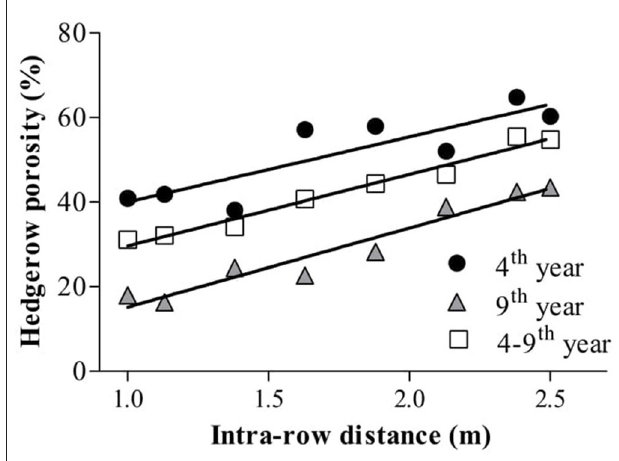
FIGURE 4 | Hedgerow porosity in the fourth and ninth year after planting trees at various intra-row distances. Average porosity from the fourth to the ninth year is also shown. Each point is a mean of 2 replicates for 8 intra-row spacings ( n = 16). The parameters of the model for 4th year were: y = 24.6 + 15.4, R 2 = 0.74; for 9th year: y = − 3.5 + 18.7x, R 2 = 0.94; and for 4–9th: y = 12.8 + 16.9x, R 2 = 0.98, where y is hedgerow